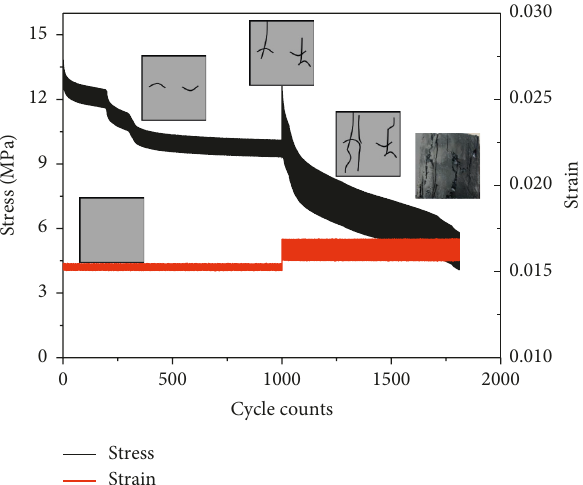
Figure 9: Failure mode of a coal sample.